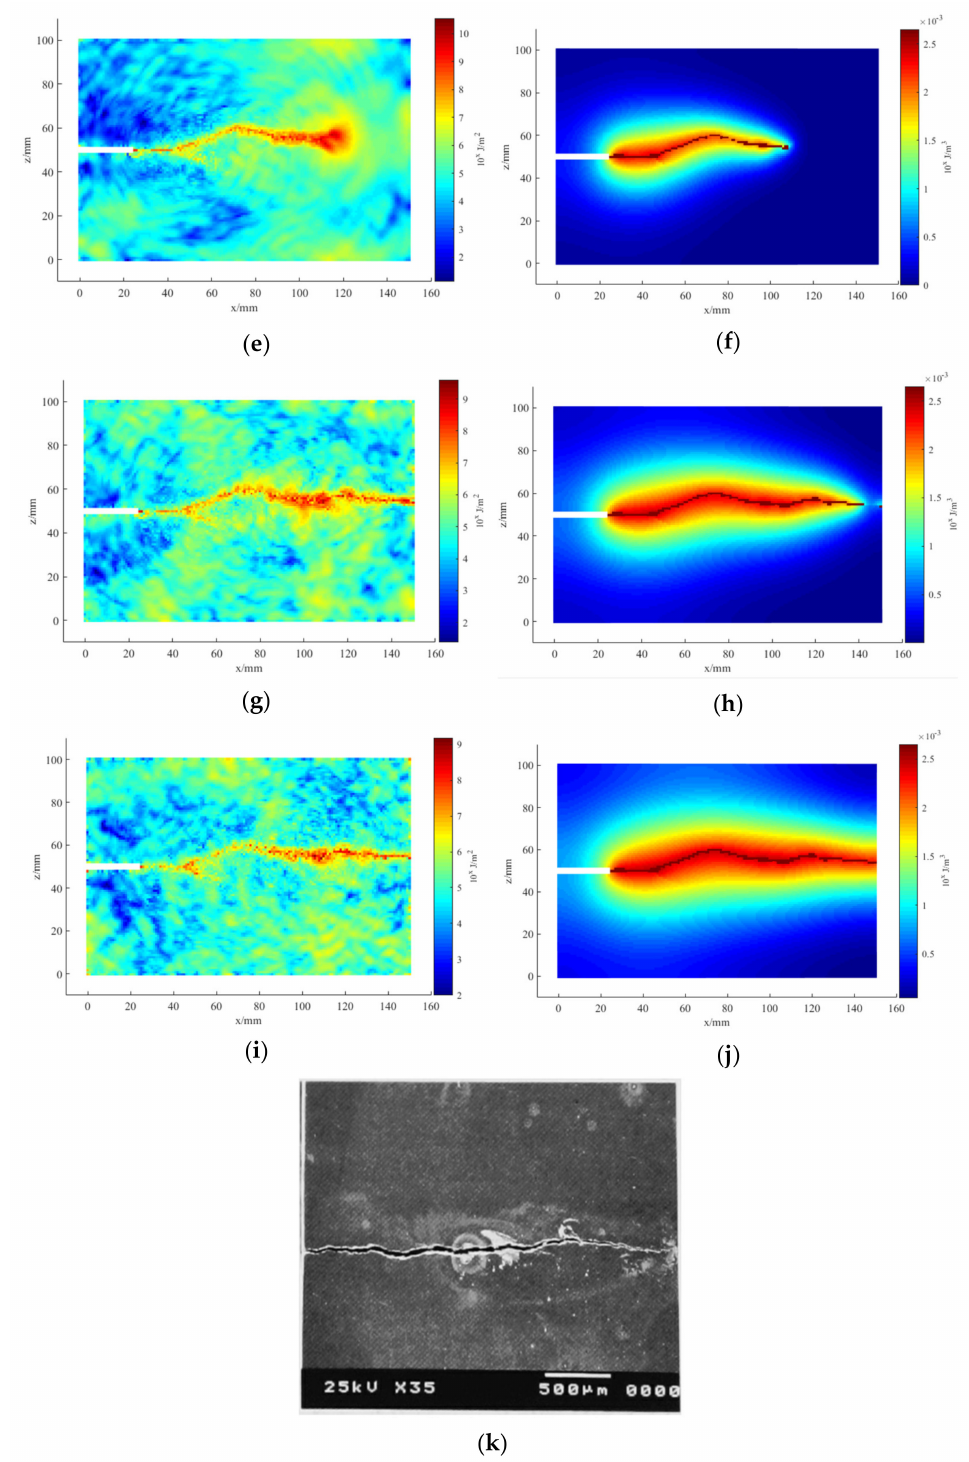
Figure 9. Energy diagram (( a ) t = 400, ( c ) t = 800, ( e ) t = 1200, ( g ) t = 1600, and ( i ) t = 2000), crack propagation path (( b ) t = 400, ( d ) t = 800, ( f ) t = 1200, ( h ) t = 1600, and ( j ) t = 2000), and an SEM image of the sample surface ( k ) when the RH was 35%, with T = 40 t and λ B = 0.5 µ